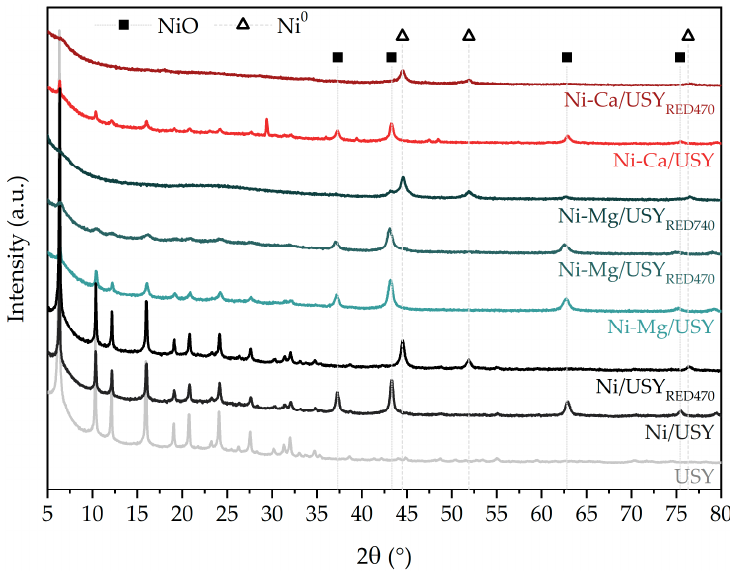
Figure 5. XRD patterns obtained for Ni-AE/USY catalysts after calcination and reduction.